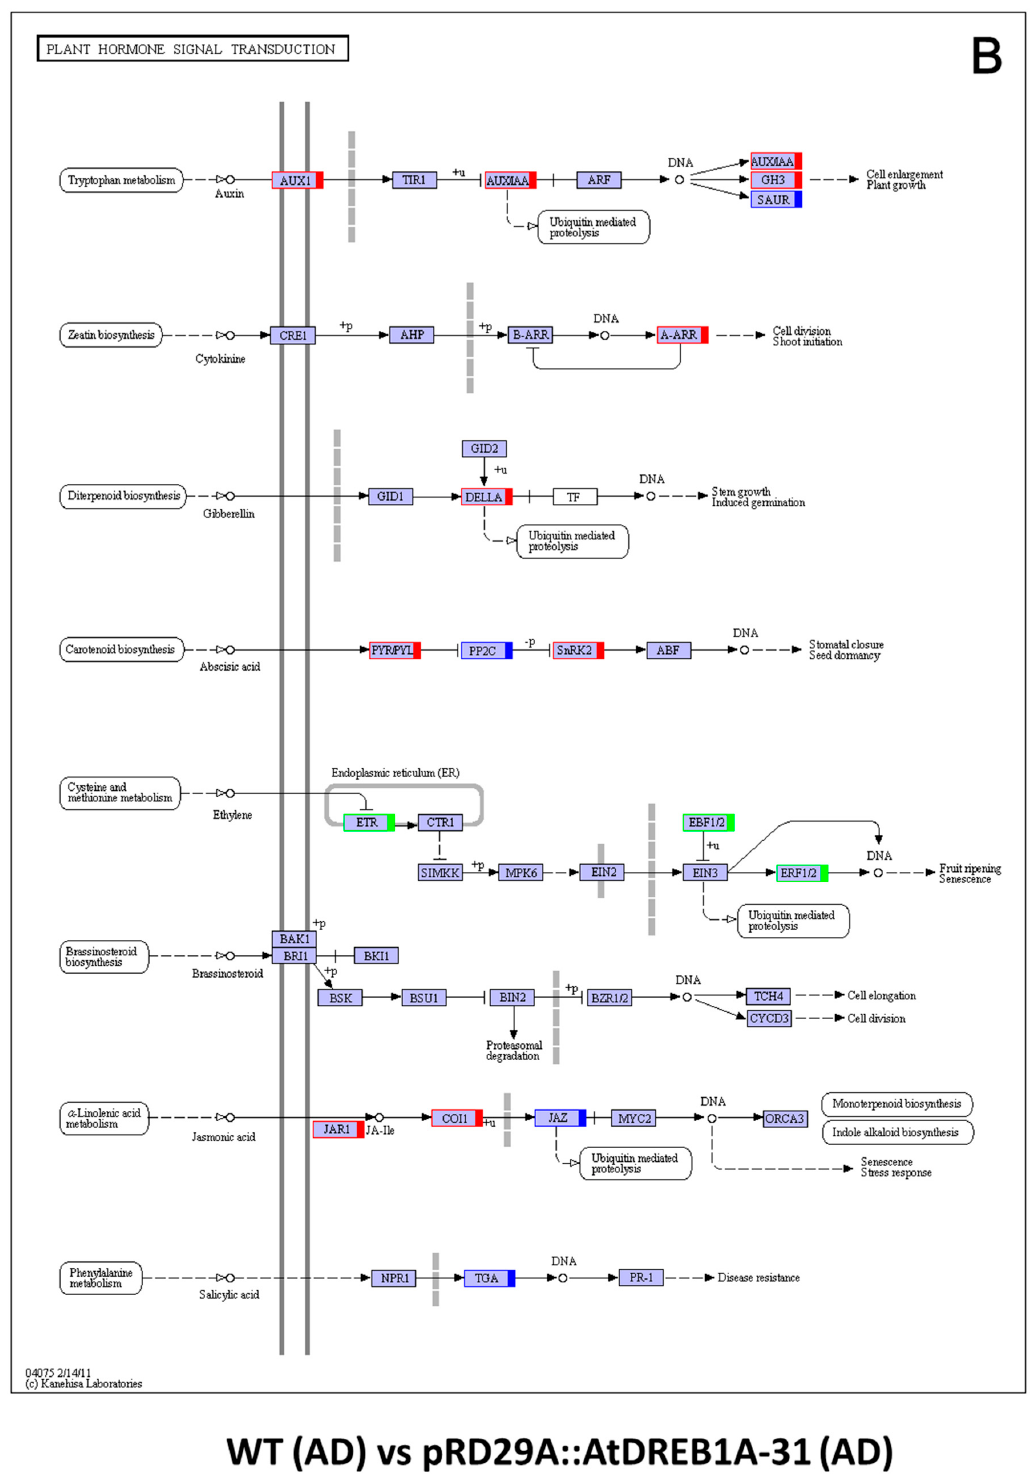
Figure 8. Analysis of DEGs related to plant hormone signal transduction in the comparisons of WT and AtDREB1A transgenic plants before and after drought treatment. ( A ) WT (BD) versus pRD29A::AtDREB1A-31 (BD); ( B ) WT (AD) versus pRD29A::AtDREB1A-31 (AD). Red/green indicate up- and down-regulated DEGs, respectively. Blue indicates DEGs with mixed patterns of regulation. WT, wild-type; pRD29A::AtDREB1A-31, pRD29A::AtDREB1A transgenic line 31. BD, before drought; AD, after six days of drought.